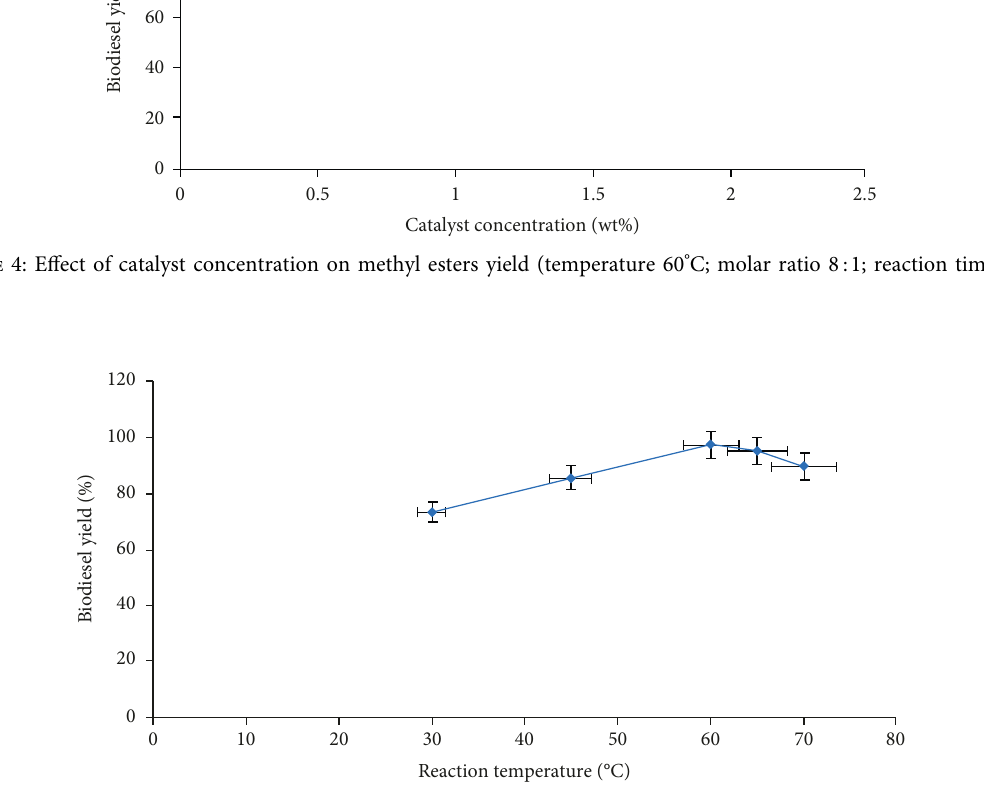
Figure 5: Effect of reaction temperature on the FAME yield (reaction temperature 60 ° C; catalyst amount 6 wt.%; reaction time, 1hrs).